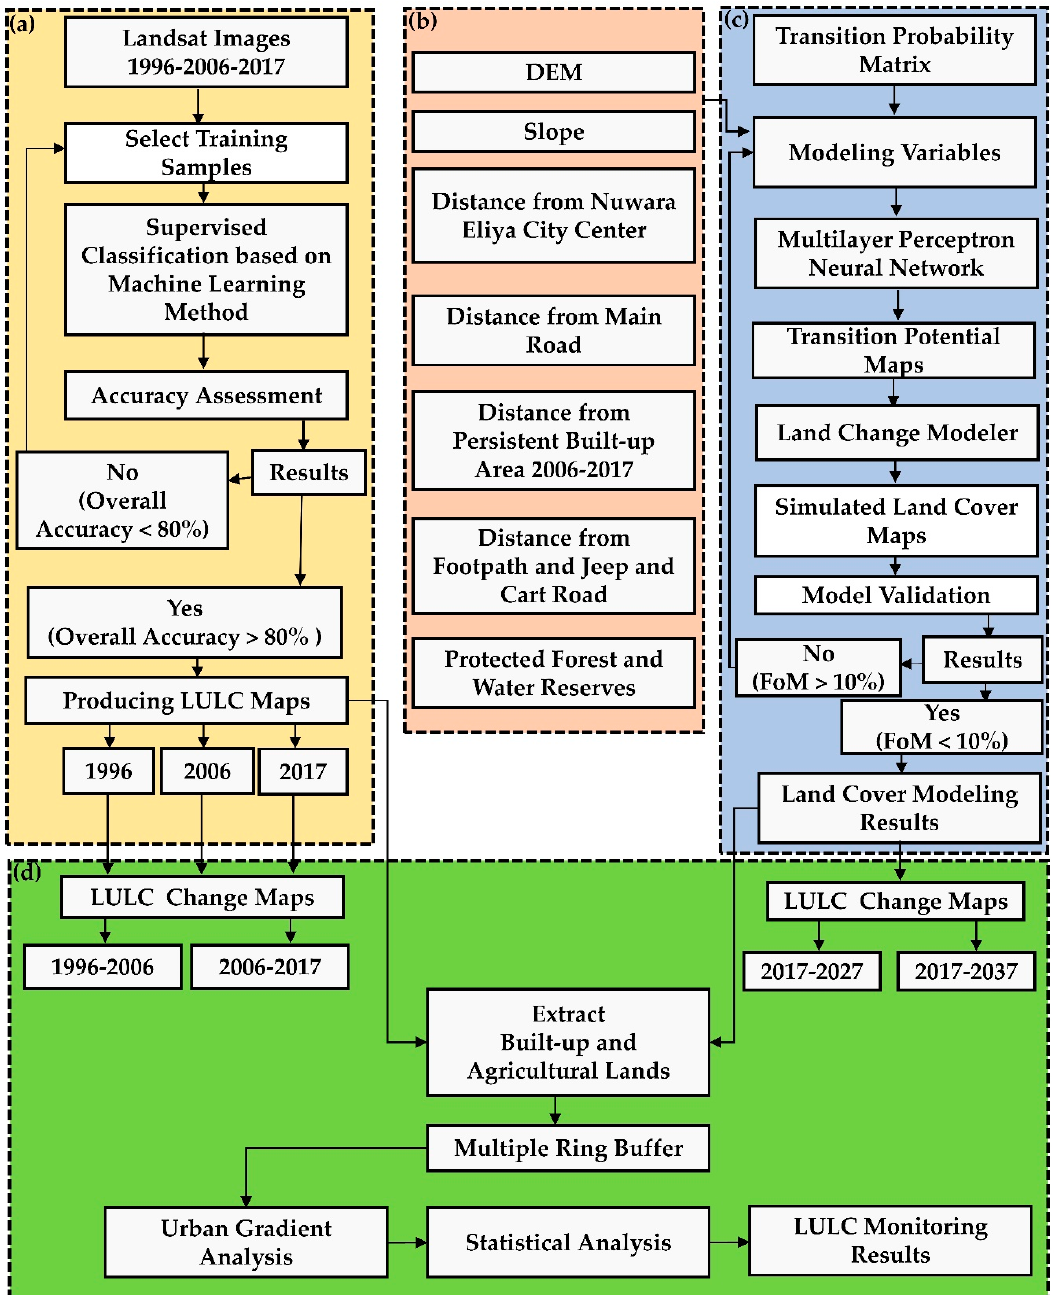
Figure 2. Workflow of the study: ( a ) Land use and land cover (LULC) classification; ( b ) Modeling variables; ( c ) Prediction of LULC changes; and ( d ) Urban–rural gradient analysis.